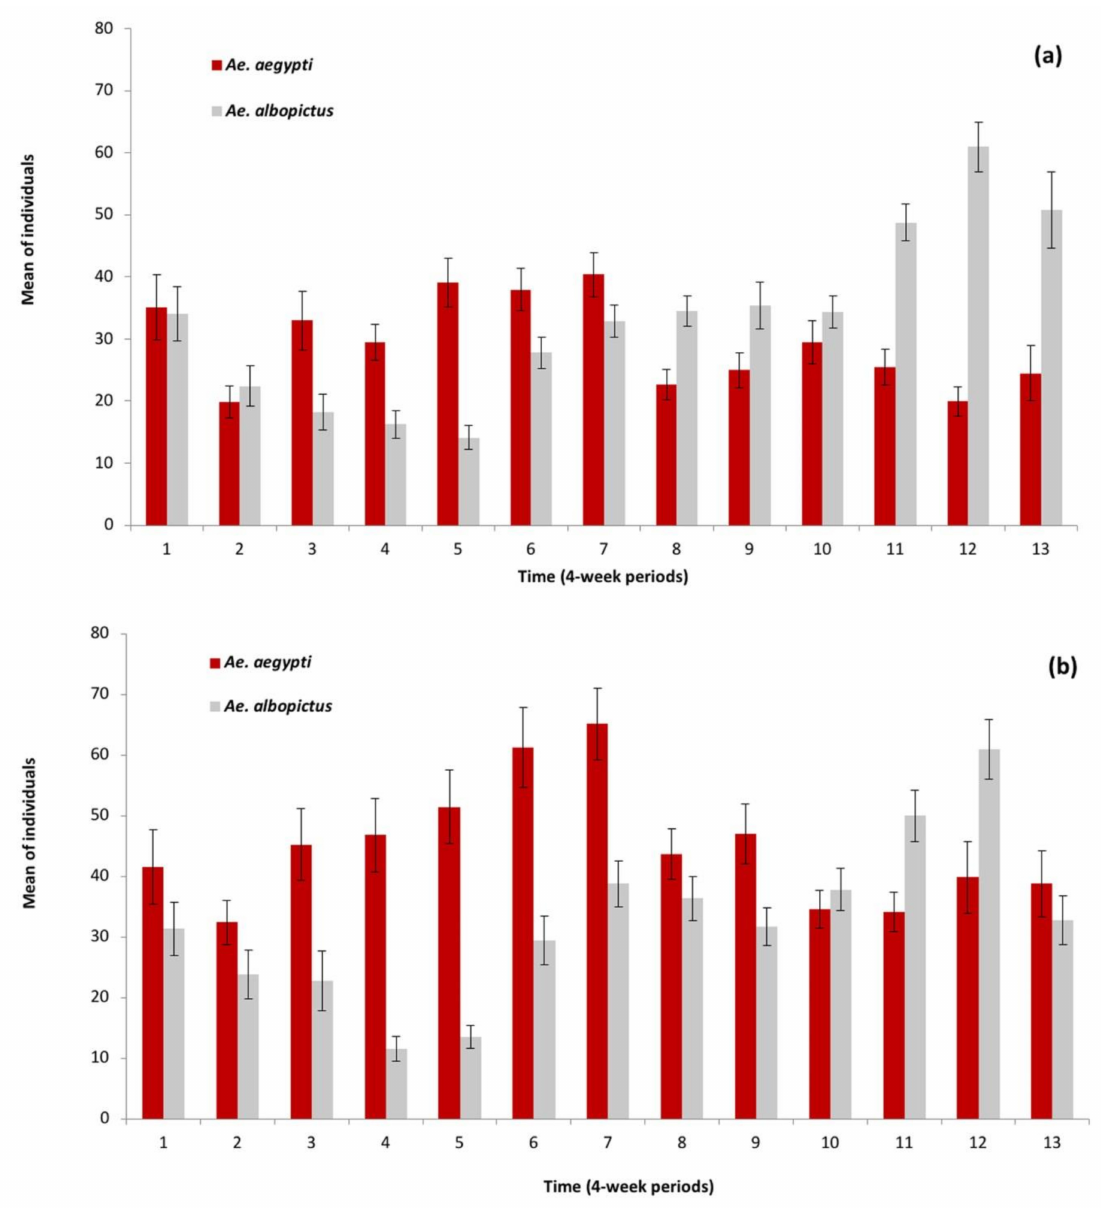
Figure 4. Mean (+SE) estimated abundance of Aedes aegypti and Ae. albopictus considering both in and outdoor traps per 4-week period during three years in: ( a ) R í o Florido, ( b ) Hidalgo. Abundance is the product of the number of eggs collected from ovitraps, egg viability (hatching), and the proportion of each species identified in laboratory-reared